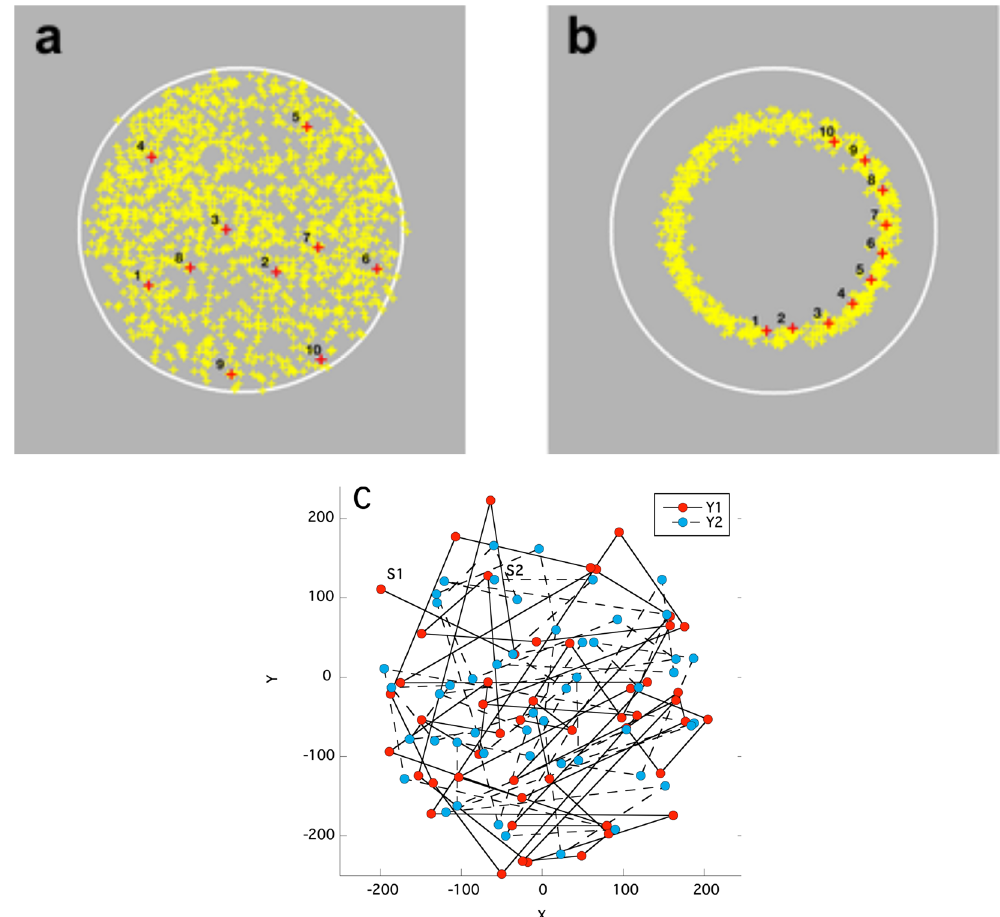
Figure 1. Location of all experimental click positions for one typical observer. ( a ) Click locations (yellow crosses) generated when requested to perform as randomly or unpredictably as possible. ( b) Locations when requested to click around an imagined, invisible circle of approximately half the diameter of the visible white outline. In each panel a sequence of ten clicks from the middle of the experiment are numbered in order and shown as red crosses to give a flavour for the temporal variation of successive click locations. In the actual experiments, only the white background circle on a grey background plus the current location of the cursor cross-hairs were visible. ( c ) The first 50 clicks in the experiment (red) and its repeat (blue). S1 and S2 indicate the first click in the first and second sequence respectively. There is no statistically significant correlation between the